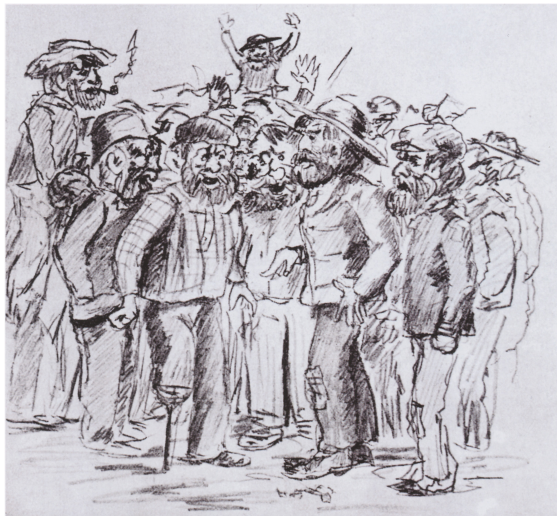
Figure 4. Pablo Picasso, Congreso de anarquistas , ca. 1893. Reproduced with permission from the Real Academia Gallega, El primer Picasso. A Coruña 2015 ; A Coruña: Museo de Bellas Artes, 2015, p. 205.